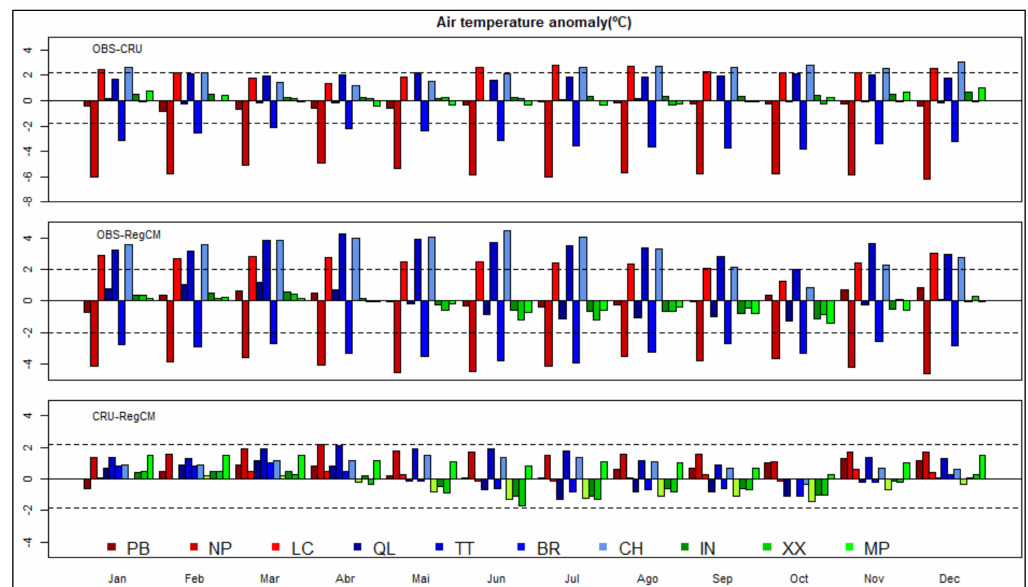
Figure 4. Monthly precipitation and air temperature anomaly (climatology, 1971 − 2000). Each bar represents the corresponding WS in the study domain. OBS, CRU and RegCM are the three datasets described as observed WS, interpolated CRU and simulated RegCM, respectively. Each bar indicate the bias for the corresponding month and WS. The horizontal dashed lines show the limit between 10 and − 10 mm/month for precipitation ( panel above ), and 2 and − 2 ◦ C for air temperature ( panel below